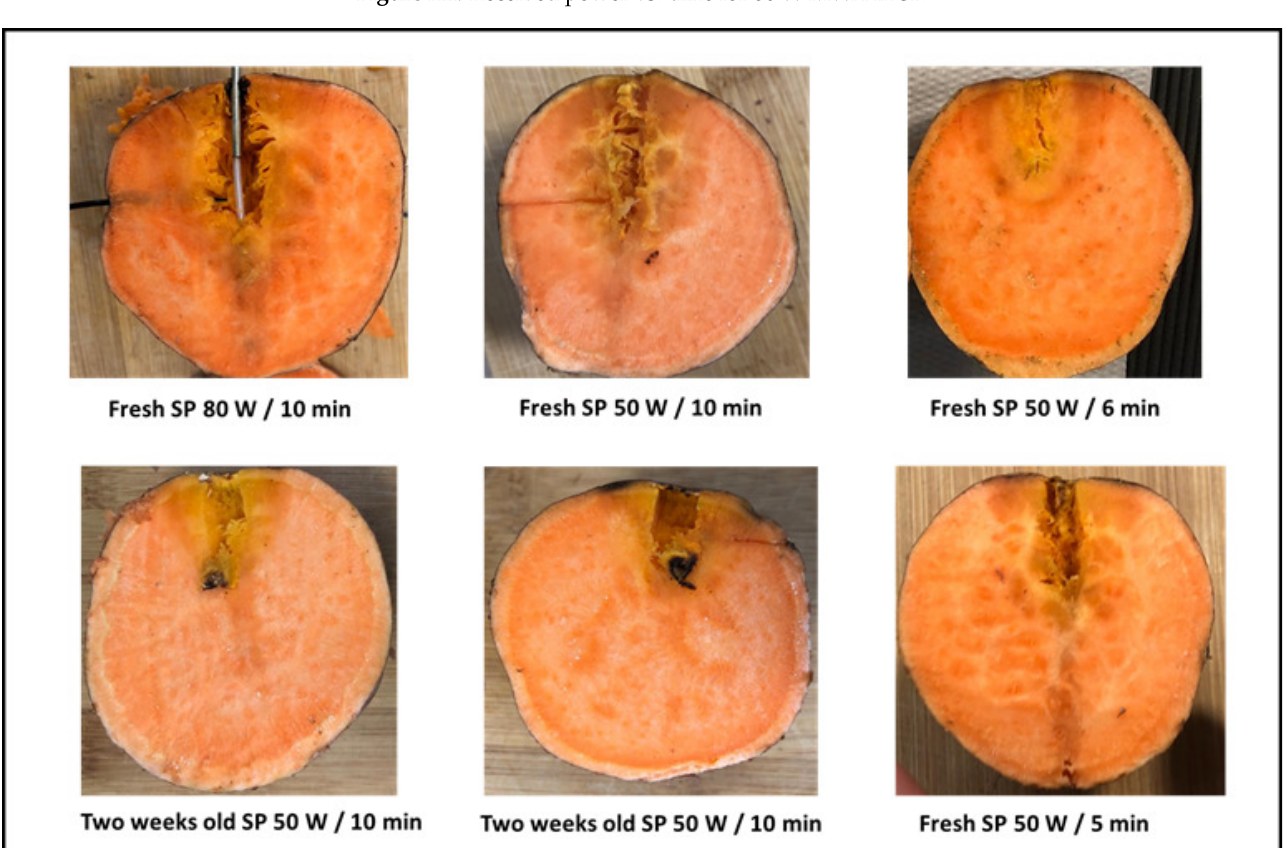
Figure A5. MWA result examples of